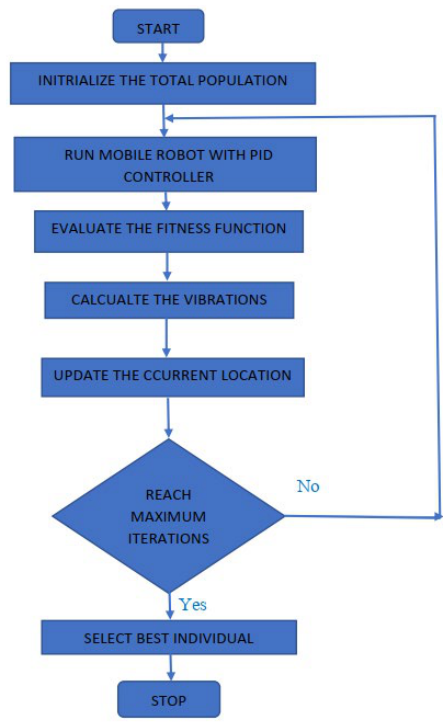
Figure 5. Flow chart of SSO algorithm.